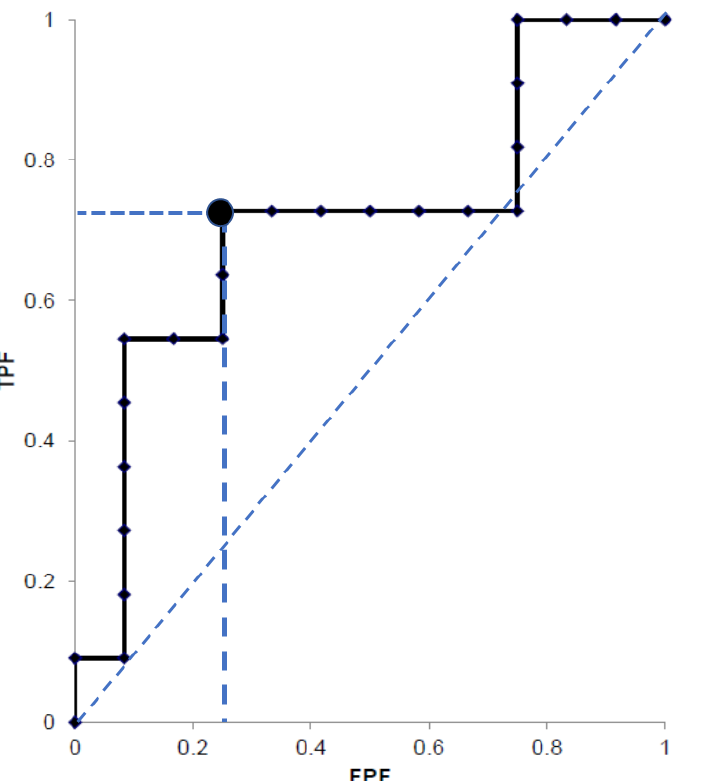
Figure 3. The best cut-off value of SWE tumor/non-tumor ratio was 2.42 to identify PDAC showing 0.7692 AUROC in the pancreatic tumors showing pattern B. TPF, true positive fraction; FPF, false positive fraction.